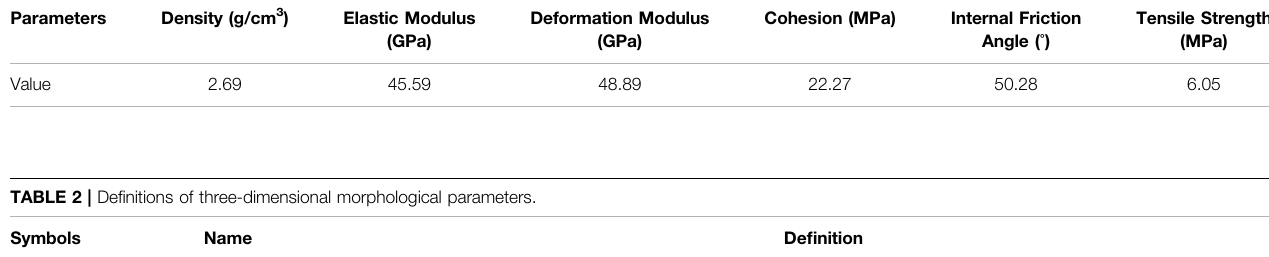
TABLE 1 | Basic physical and mechanical parameters of the rock sample.